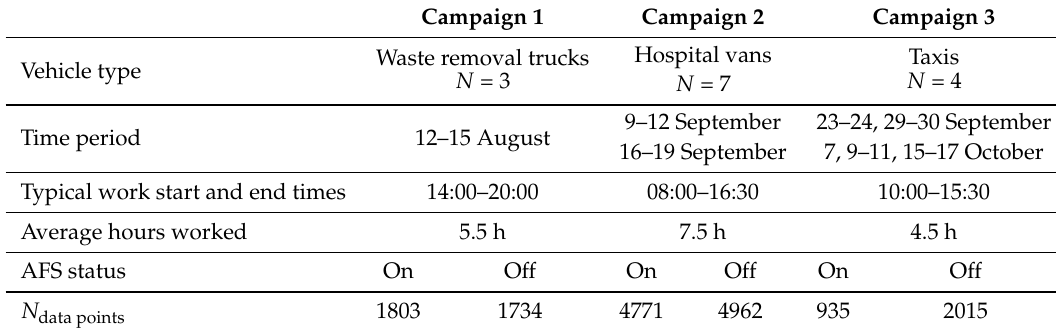
Table 3. Characteristics of the